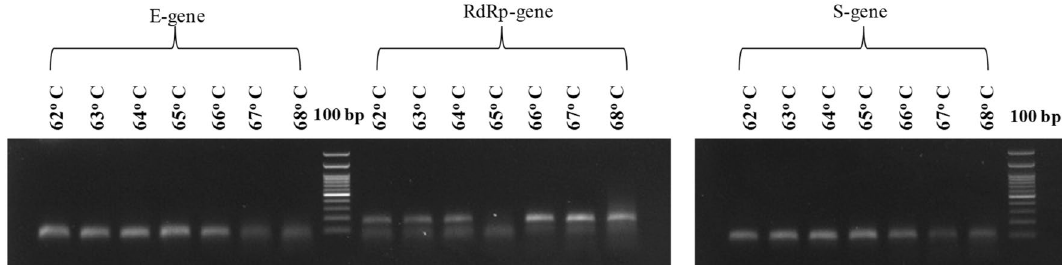
Figure 1. Amplification of E, RdRp and S genes at different temperature in gradient PCR. (Lane 1–7 E-gene, Lane 8 100 bp ladder, Lane 9–15 RdRp-gene, Lane 16–22 S-gene, Lane 23 100 bp ladder.